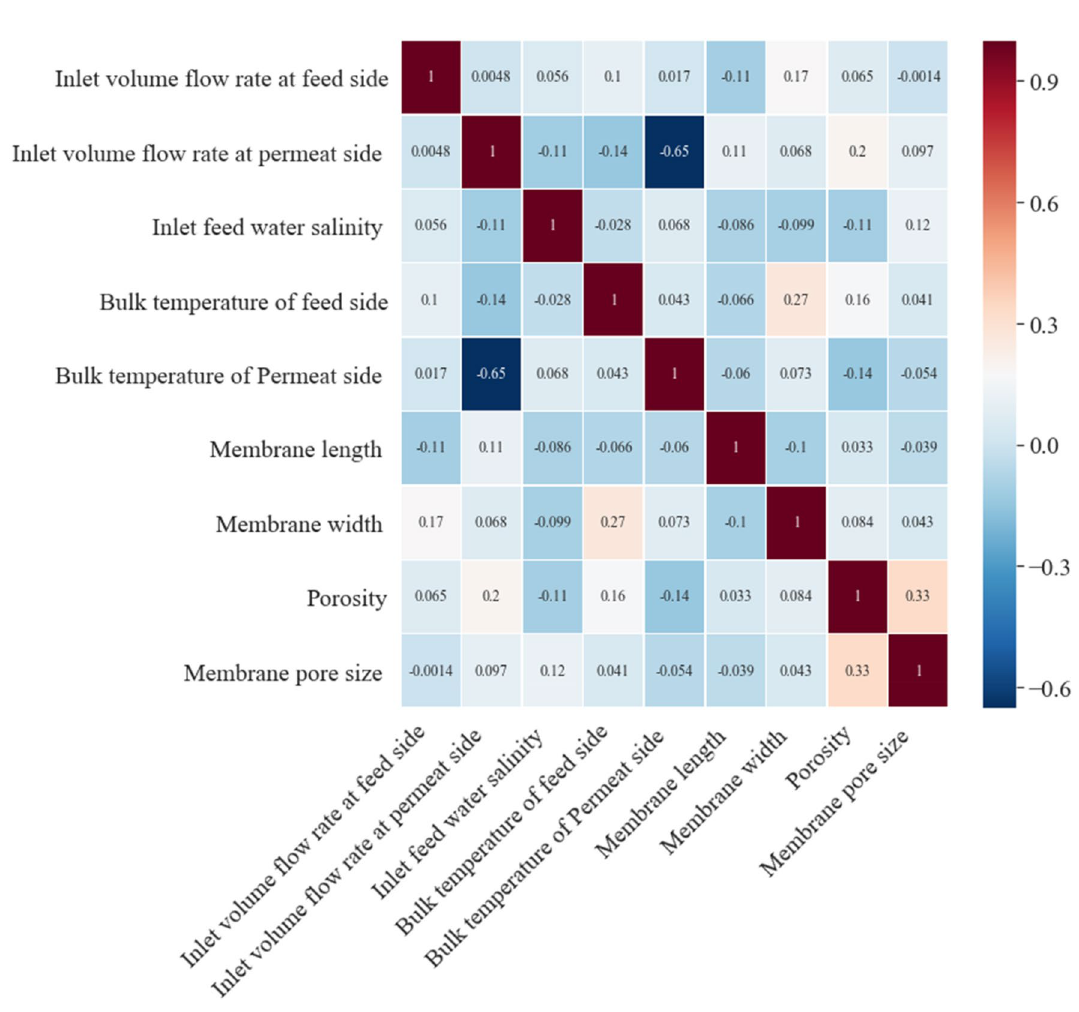
Figure 8. The Pearson correlation coefficient of decision